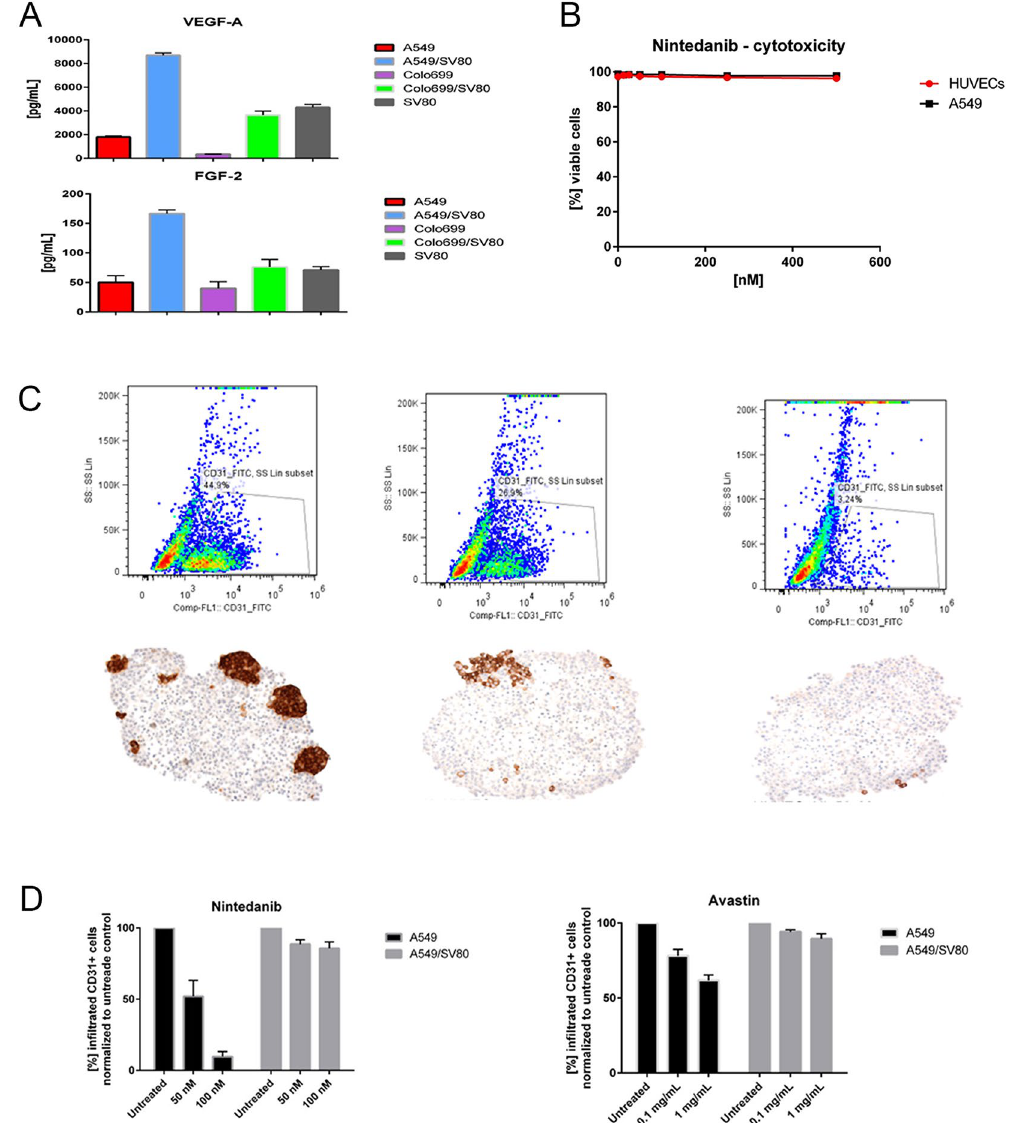
Figure 3. Cytokine secretion profile and anti angiogenic drug incubation: ( A , B ) Supernatants from monocultures (A549, Colo699, SV80) and co-cultures (A549/SV80), Colo699/SV80) were harvested on the day endothelial cells were added and analysed by a multiplex immunoassay (ProcartaPlex Human Growth Factor Panel 11 plex” – immunoassay). Co-cultures of cancer cells with fibroblasts delivered high amounts of pro-angiogenic factors (vascular endothelial growth factor (VEGF) and fibroblast growth factor (FGF)). ( C ) Dose depending cytotoxicity of nindetanib on cancer cells and endothelial cells. No dose depending cytotoxicity was measured for both cell lines. D + E Blocking endothelial cell migration into microtissues by inhibition of angiogenesis. Either bevacizumab or nindetanib were added to tri-cultures for 48 hours. Migration of endothelial cells into microtissues was displayed either by flow cytometry or IHC. Incubation with the two substances led to a decrease or a complete stop in migration of endothelial cells. A dose depending effect on the inhibition of endothelial cell migration was